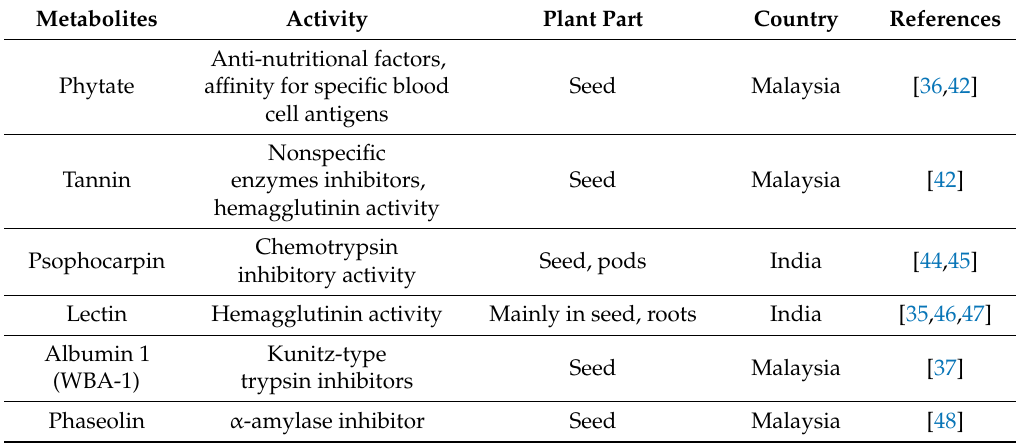
Table 2. Main metabolites responsible of the biological activity of Psophocarpus